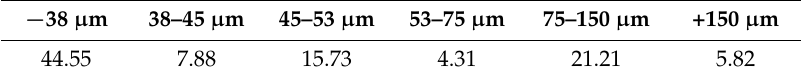
Table 5. Size distribution of CVTM (wt %).